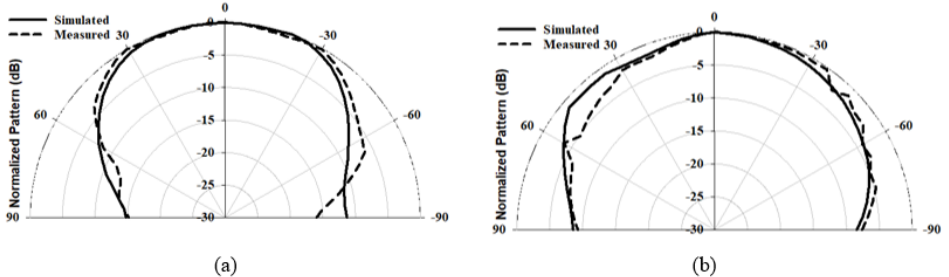
Figure 13. Radiation pattern of a hemispherical DRA with the added substrate at 24 GHz ( a ) φ = 0 ◦ ( b ) φ = 90 ◦ .